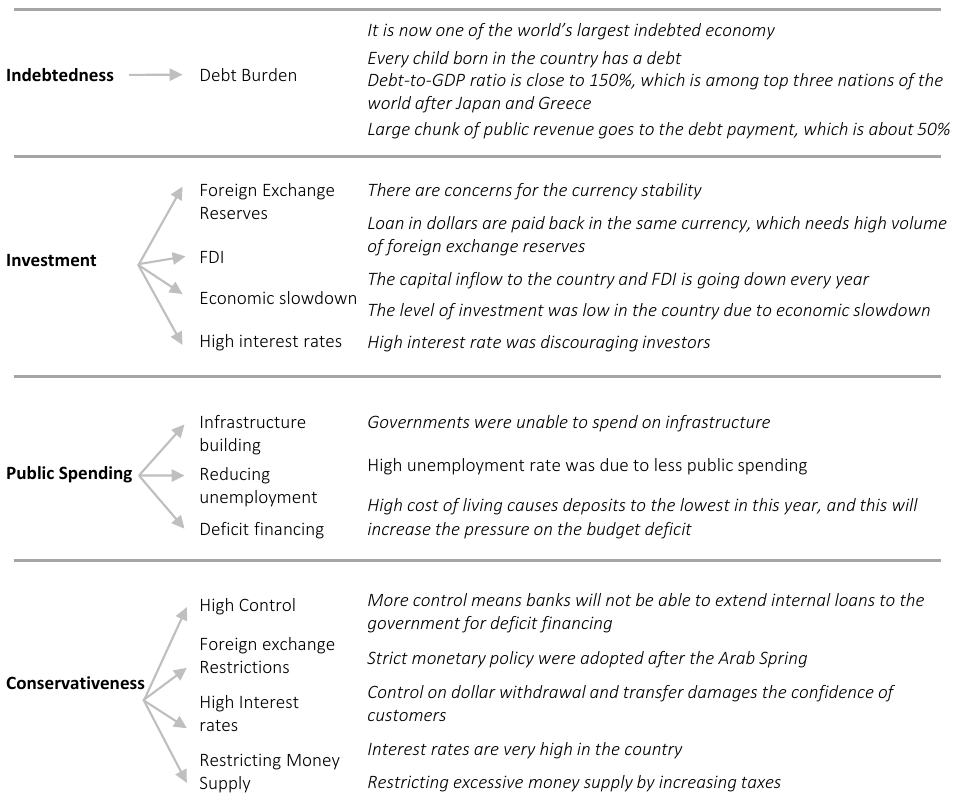
Theme of Fiscal & Monetary